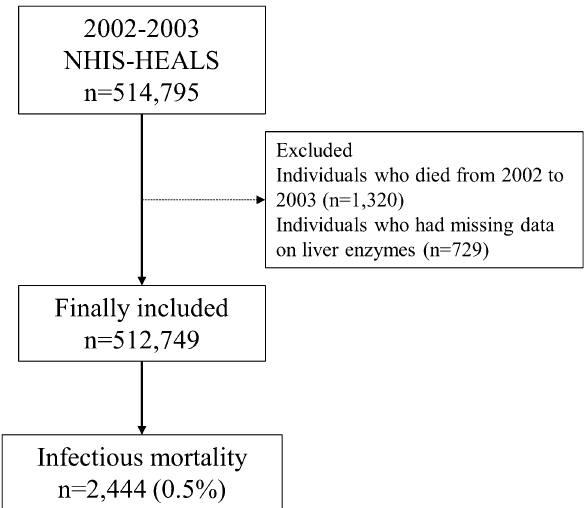
Figure 1. Flow chart depicting the enrolment process. NHIS-HEALS, National Health Insurance Service- National Health Screening